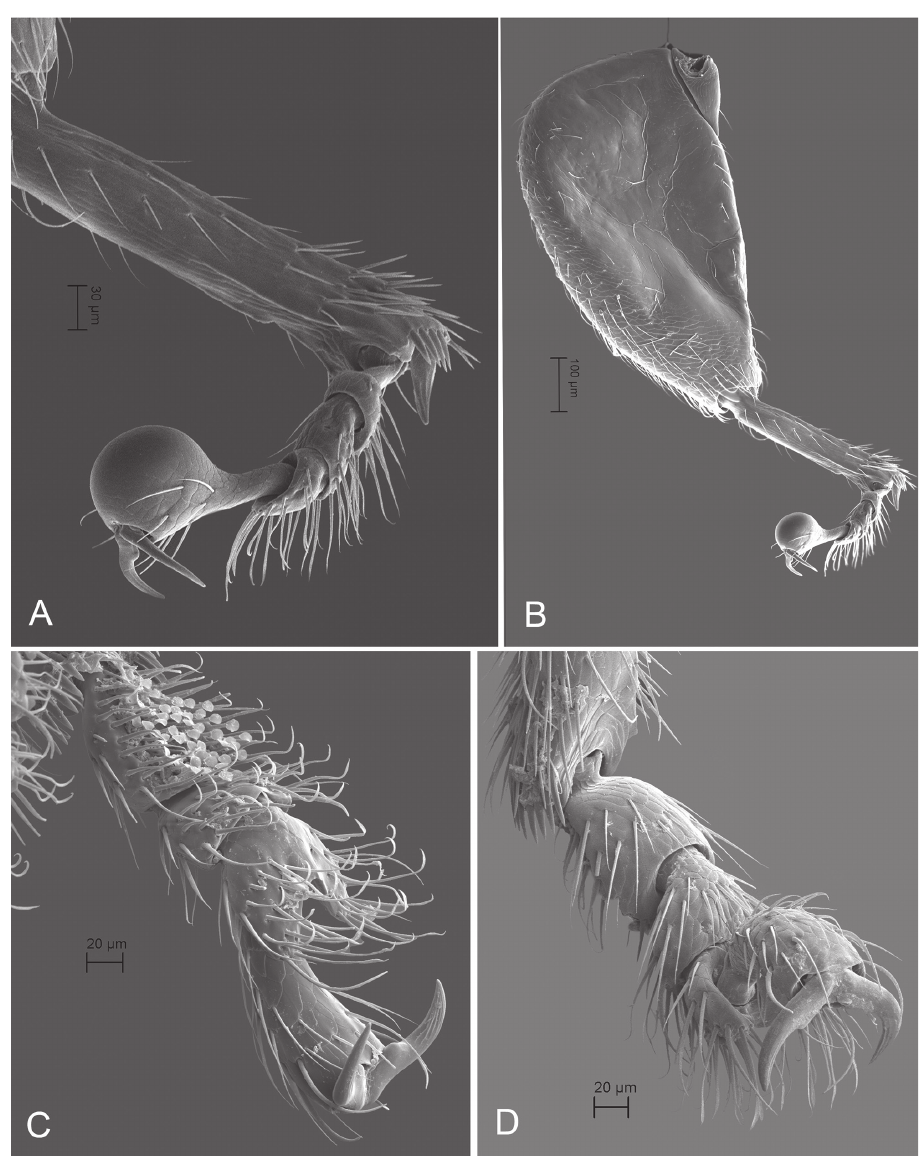
Figure 27. Andersonoplatus microoculus . A Hind tibia and tarsus in dorsal view B Hind leg in dorsal view C Protarsomeres in ventral view D Protarsomeres in dorsal view. Andersonoplatus peck sp. n. http://zoobank.org/B35E4FF6-541D-4124-8EFD-F533B99B32D1 Figs 28, 29 Description. Body length 1.62–1.78 mm, width 0.81–0.91 mm, shiny, pilose, with semi-erect hairs, flat in lateral view. Color light